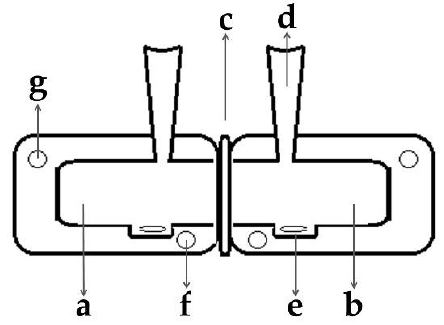
Figure 1. Schematic of the side-by-side diffusion system. Heatable double wall donor cell with a nominal volume of 4 mL ( a ), heatable double wall receptor cell with a nominal volume of 4 mL ( b ), position of the semipermeable cellulose membrane ( c ), sampling port ( d ), magnetic stir bar ( e ), water inlet ( f ) and water outlet ( g ).